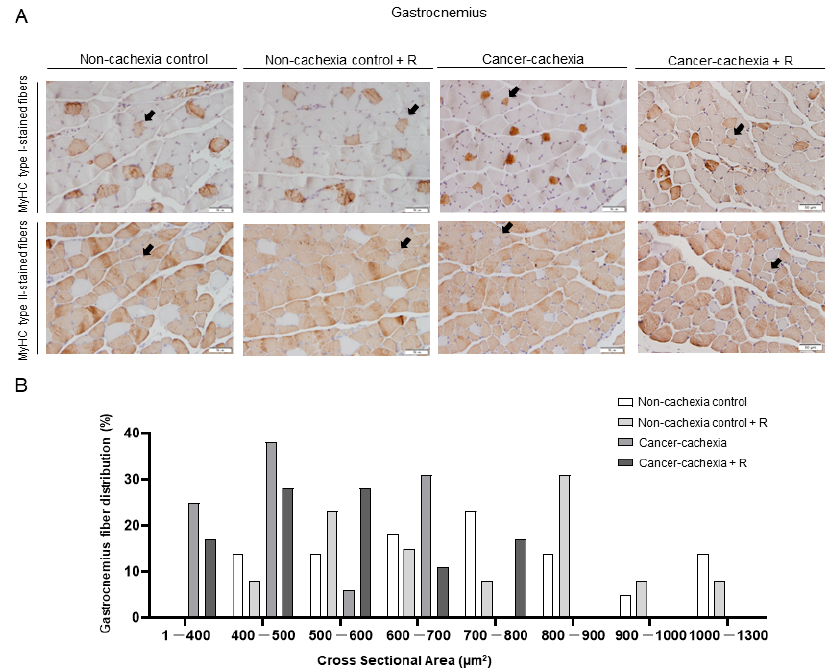
Figure 4. Representative images of gastrocnemius muscle fibers ( A ). Myofibers with anti-MyHC type I antibody staining (brown color) are shown in the top panel and anti-MyHC type II antibody staining in the middle panel. Hybrid fibers (arrows) are seen in both panels. Schematic representation of the distribution of the CSA of the muscle fibers in the gastrocnemius muscle ( B ). Abbreviations: R, rucaparib; MyHC, myosin heavy chain; CSA, cross-sectional area.